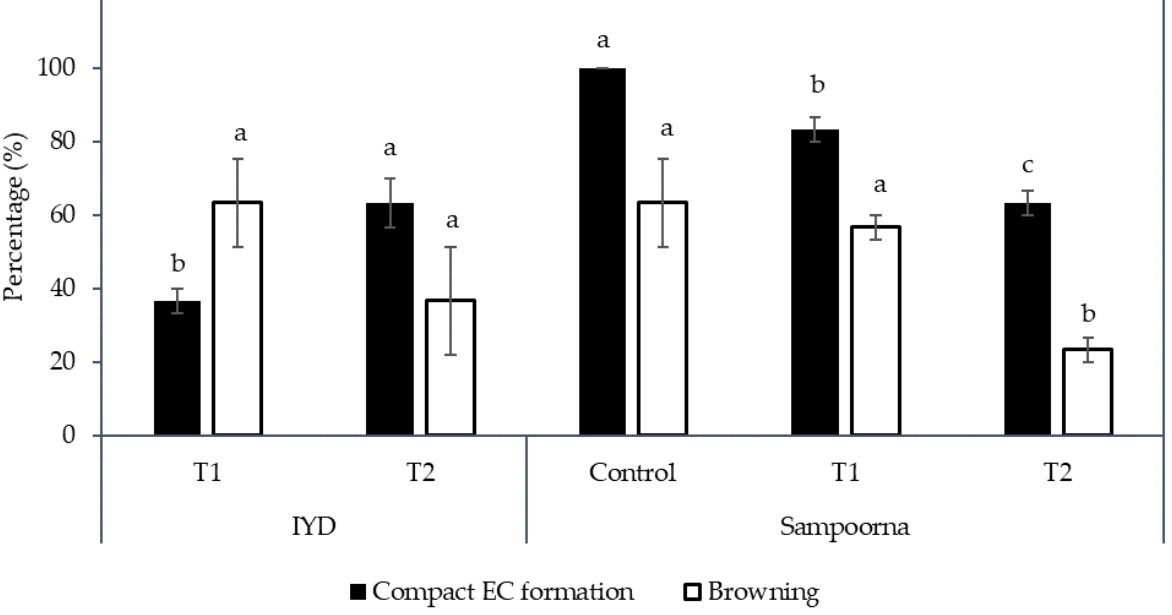
Figure 7. The effect of reduced nutrients (Control, T1, and T2) on the percentage of compact embryo- genic callus (EC) formed and explants with necrosing (Browning) tissues. Mean value ± standard error is presented on each bar. The mean value of each treatment for each coconut variety followed by different letter was significantly different (Tukey’s test, p ≤ 0.05); n = 3. Control: Eeuwens Y3 medium; T1: Modified Eeuwens Y3 medium with only 10% N, P, and K and 10 mg L −1 thiamine hydrochloride; T2: Gresshoff and Doy (GD) medium.